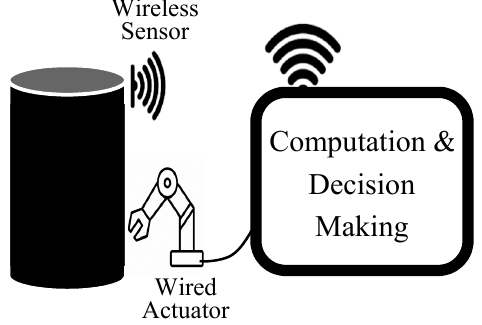
Figure 1. Cyber–physical Systems (CPS) components connected by wired and wireless networks.